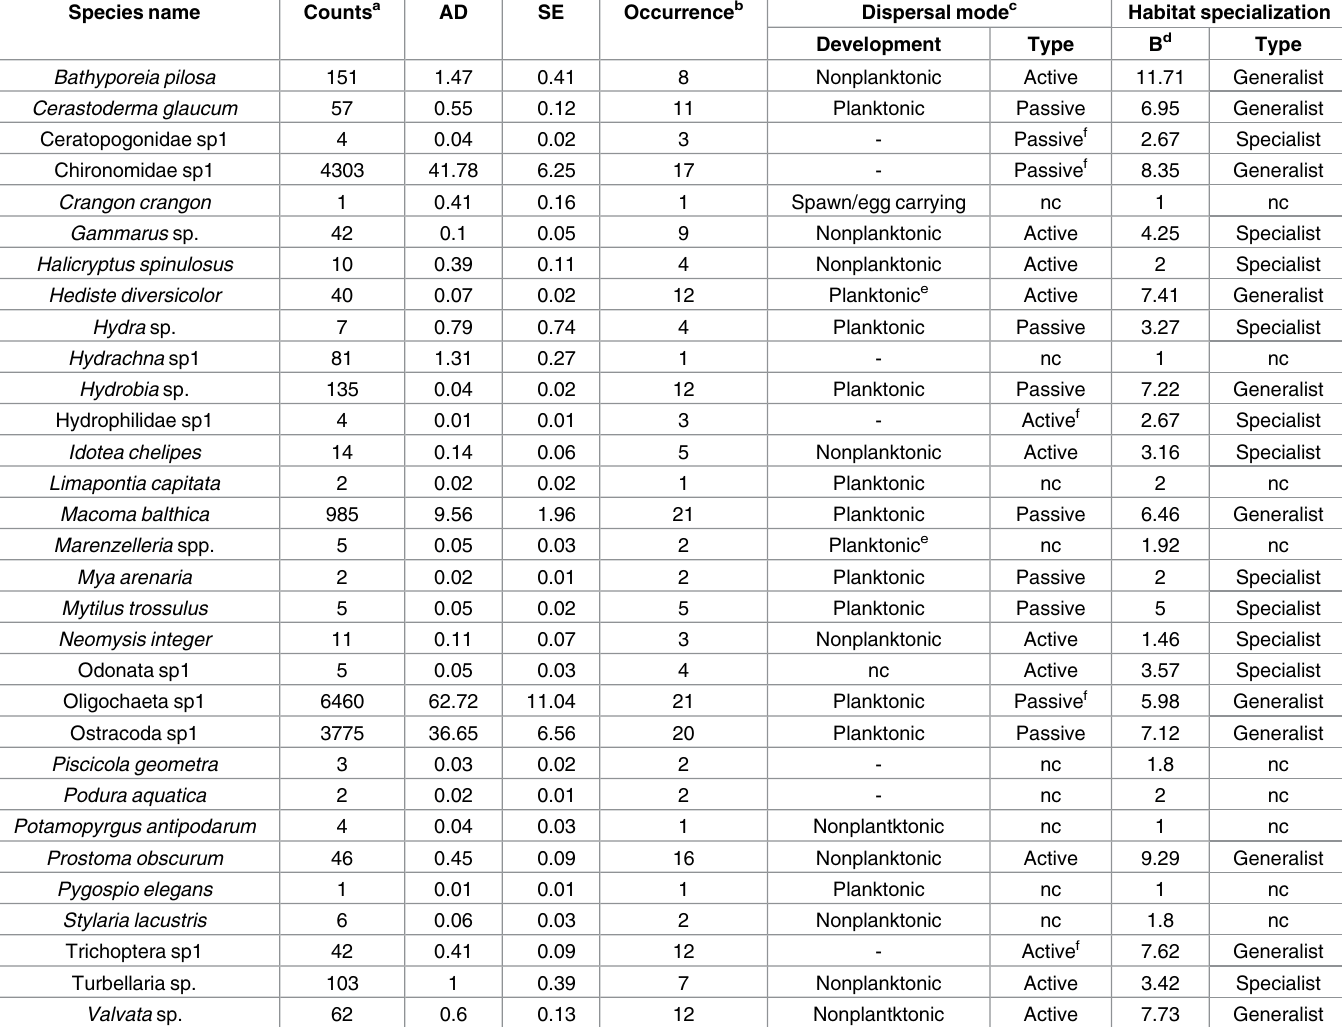
Table 1. Descriptivestatistics of the data set. AD: averagedensity (individuals per core sample, area = 25 cm 2 ) of each taxa across all beach sites, SE: standarderror; B: niche